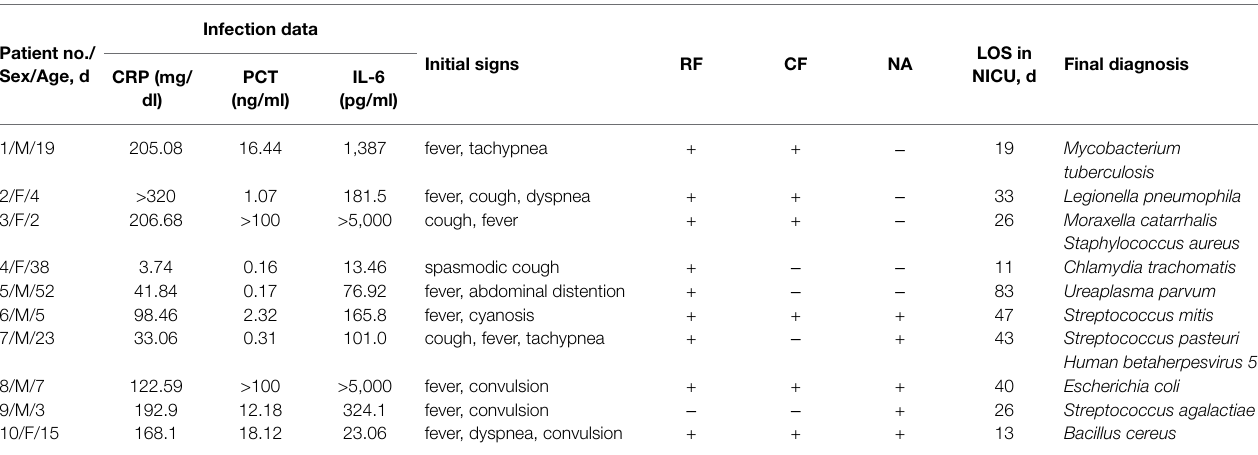
TABLE 1 | Clinical characteristics of the 10